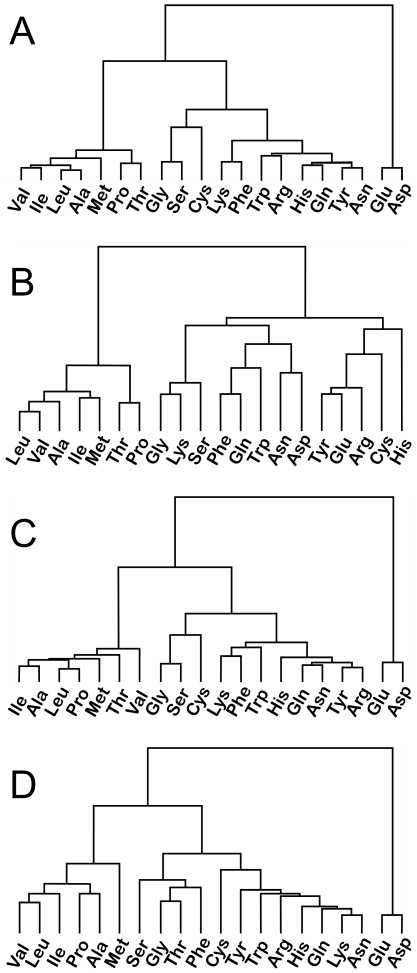
Dendograms indicating clustering of residues with respect to average HINT score (normalized by weighted count) in Res1-H2O-Res2 interactions.(A) for all waters; (B) for waters with Relevance to neither protein; (C) for waters with Relevance to one protein; and (D) for waters with Relevance to both proteins.